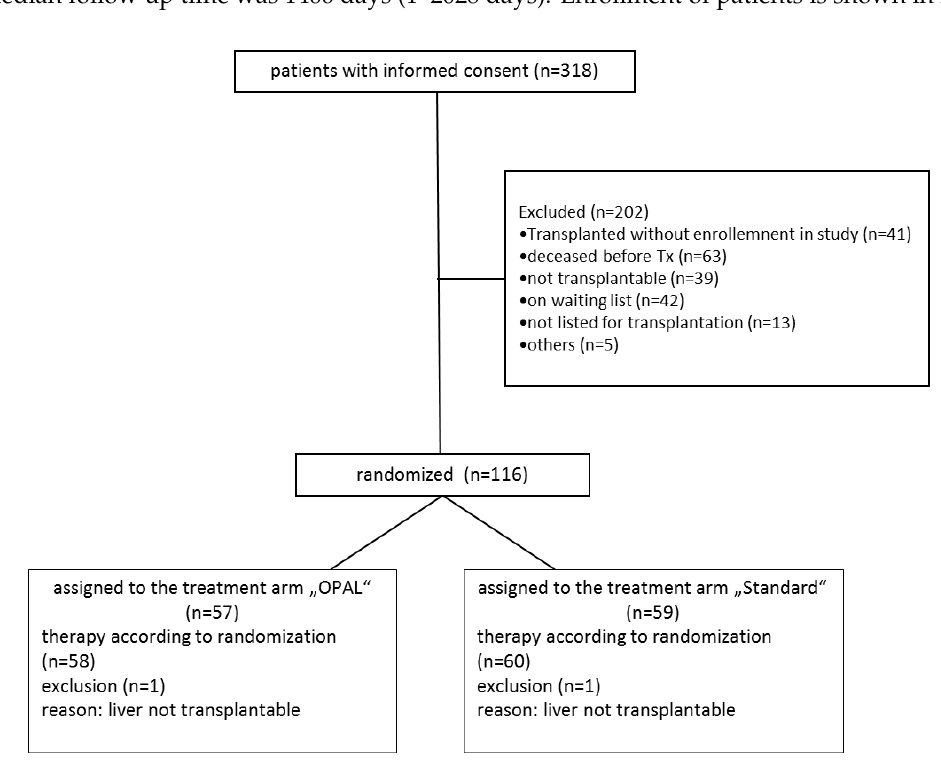
Figure 1. CONSORT diagram illustrating the study enrollment.